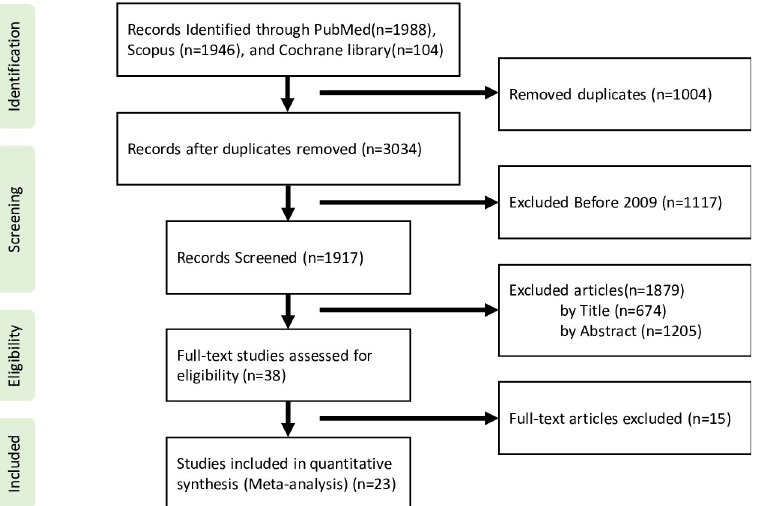
Fig 1. PRISM flowchart of article selection. The systematic review and meta-analysis were conducted according to guidelines recommended by PRISMA.